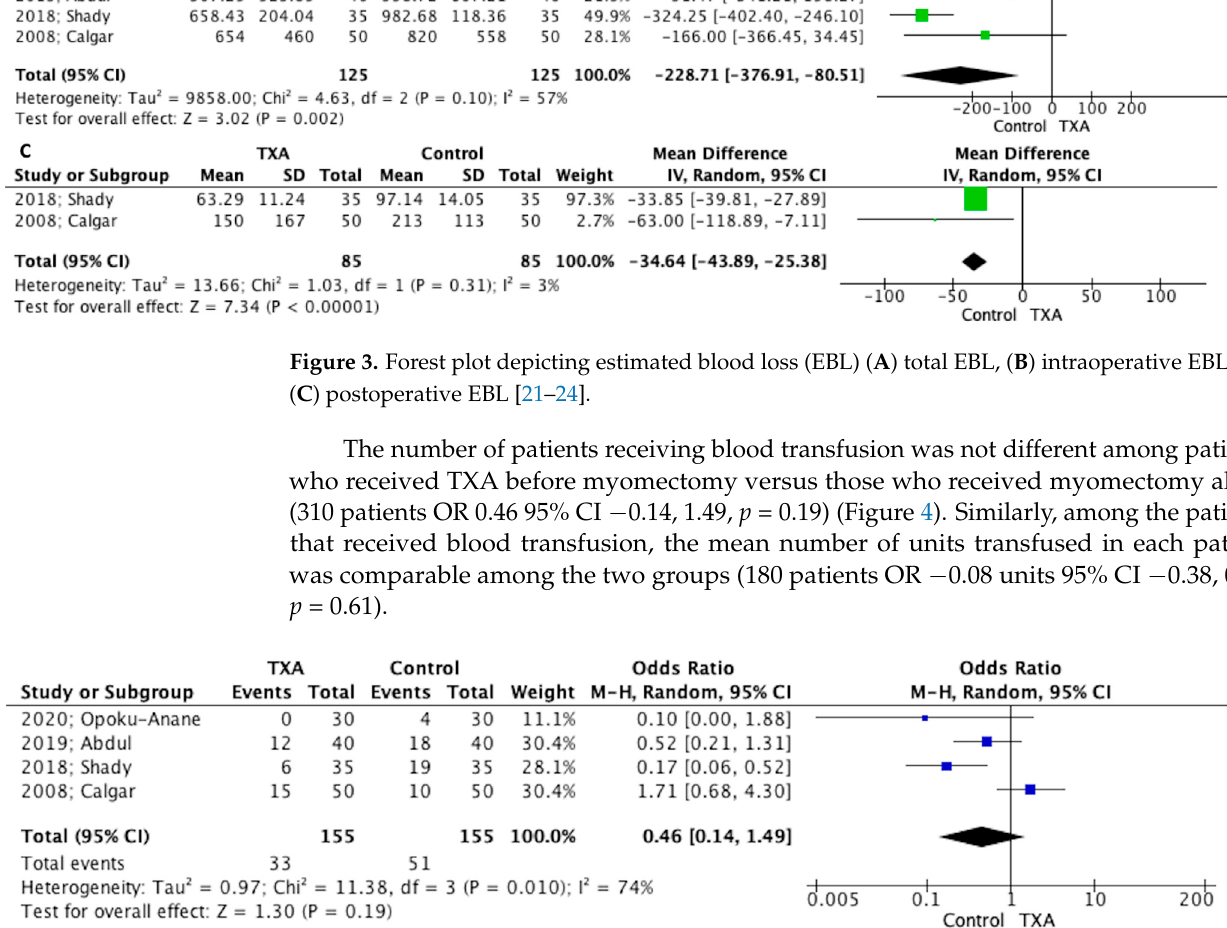
Figure 4. Forest plot depicting blood transfusion [13–16] .